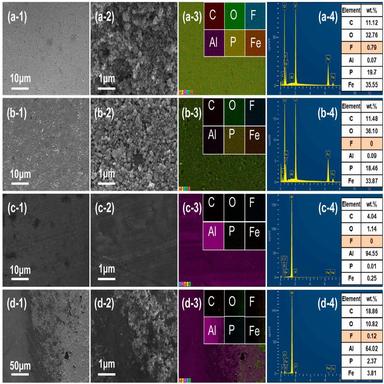
Analytical results of SEM-EDS of (a). Raw LFP cathode; (b). Separated CMs powders; (c). Separated Al foil with EAOP and (d). Separated Al foil without EAOP.